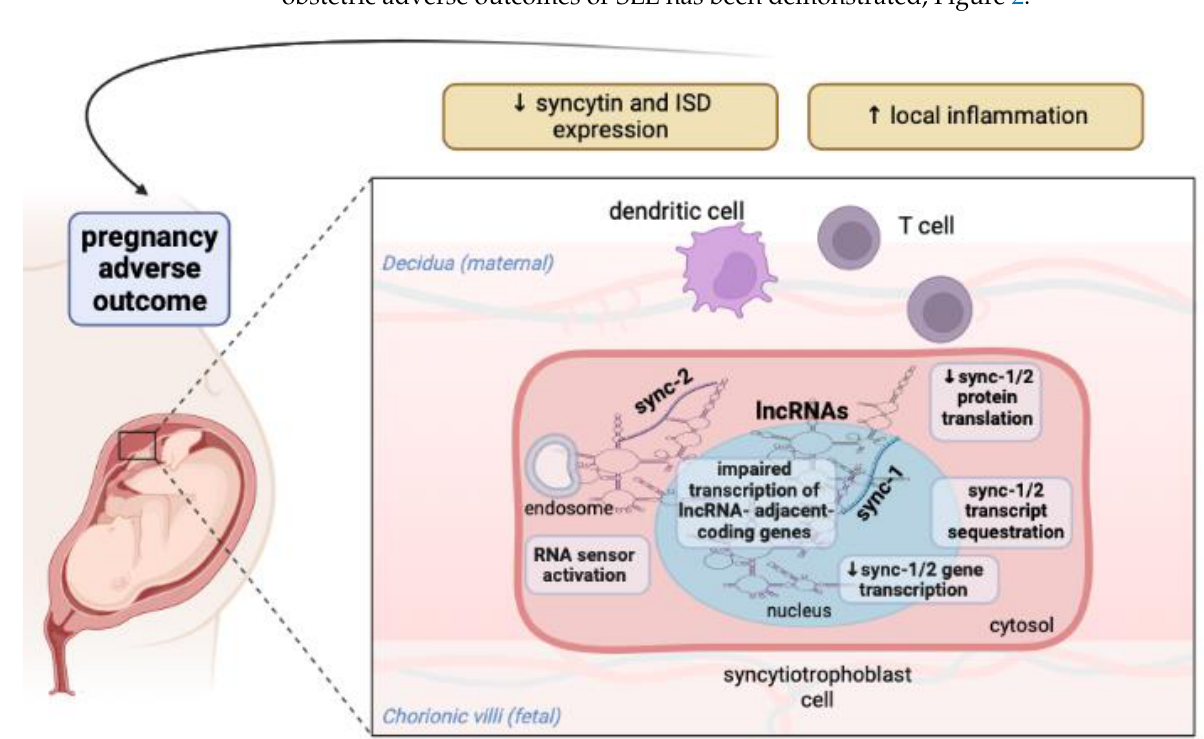
Figure 2. Hypothetical mechanisms triggered by abnormal expression of lncRNAs in the syncytiotro- phoblast of pregnant women with SLE. LncRNAs may associate with syncytin-1 and syncytin-2 genes or transcripts in the nucleus or cytosol. Such interactions may prevent transcription of syncytin-1 and syncytin-2 genes, induce sequestration of transcripts, or affect mRNA splicing and translation. Meanwhile, nucleic acid accumulation in the cytosol could fuel inflammation by stimulating RNA sensing platforms and triggering a type I IFN response. The result would be decreased expression of syncytin-1 and syncytin-2 and local inflammation with adverse effects on pregnancy outcome. On the other hand, alignment of lncRNAs with the syncytin-1 or syncytin-2 nucleotide sequence may affect transcription of neighboring protein-coding genes involved in placentation or the control of inflammation (ISD: immunosuppressive domain; lncRNAs: long noncoding RNAs; sync: syncytin). The figure was created with BioRender.com.